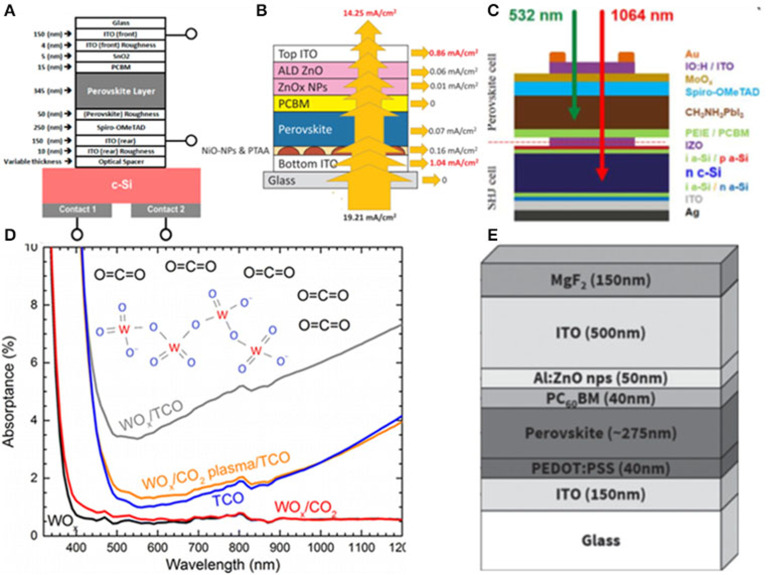
(A) Device structures of the 2T PVSK/Si tandem solar cell (reproduced from ref. 19, copyright 2017, Nature Energy). (B) Detailed optical loss analysis of ST-PSCs in NIR (800–1,200 nm). ITO layer thickness is set at 140 nm (reproduced from ref. 20, copyright 2018, Elsevier). (C) Schematic of the monolithic PVSK/Si tandem cells (reproduced from ref. 10, copyright 2016, ACS). (D) Absorption spectra and tauc plots of ~10 nm-thick evaporated MoOx, WOx, and V2Ox layers on glass (reproduced from ref. 21, copyright 2016, ACS). (E) Illustrative schematic of the device architecture showing the ITO electrode encapsulation layer (reproduced from ref. 22, copyright 2016, Wiley VCH).